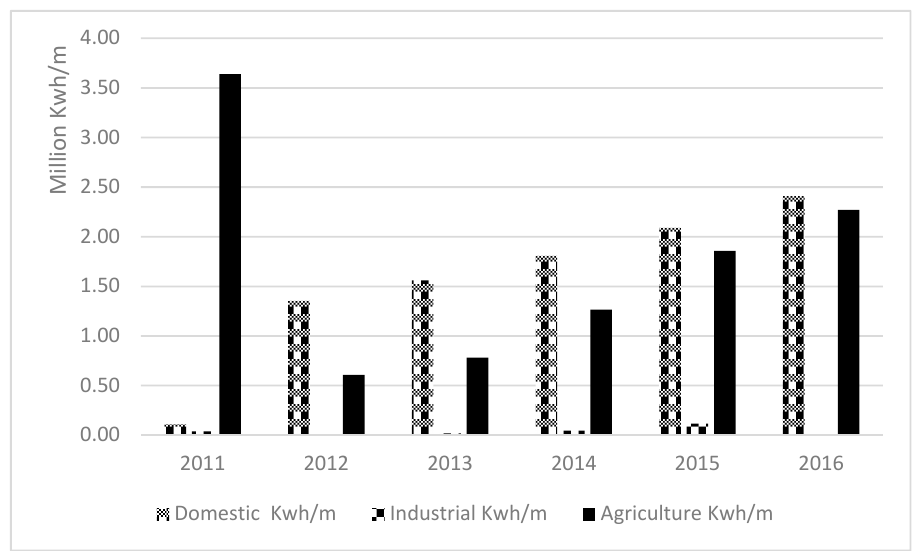
Figure 6. Northern State electricity use in million Kwh . Source: Sudanese Electricity Distribution Ltd. 2017.